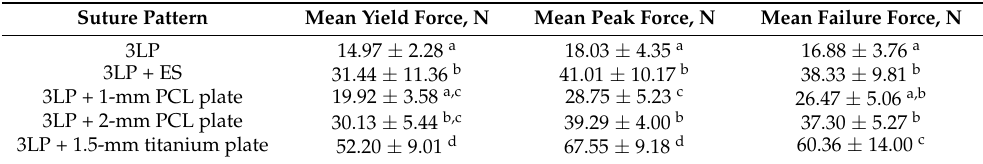
Table 1. Mean ± SD yield, peak, and failure forces for canine gastrocnemius tendons that underwent transverse tenotomy and repair with various suture patterns. Suture Pattern